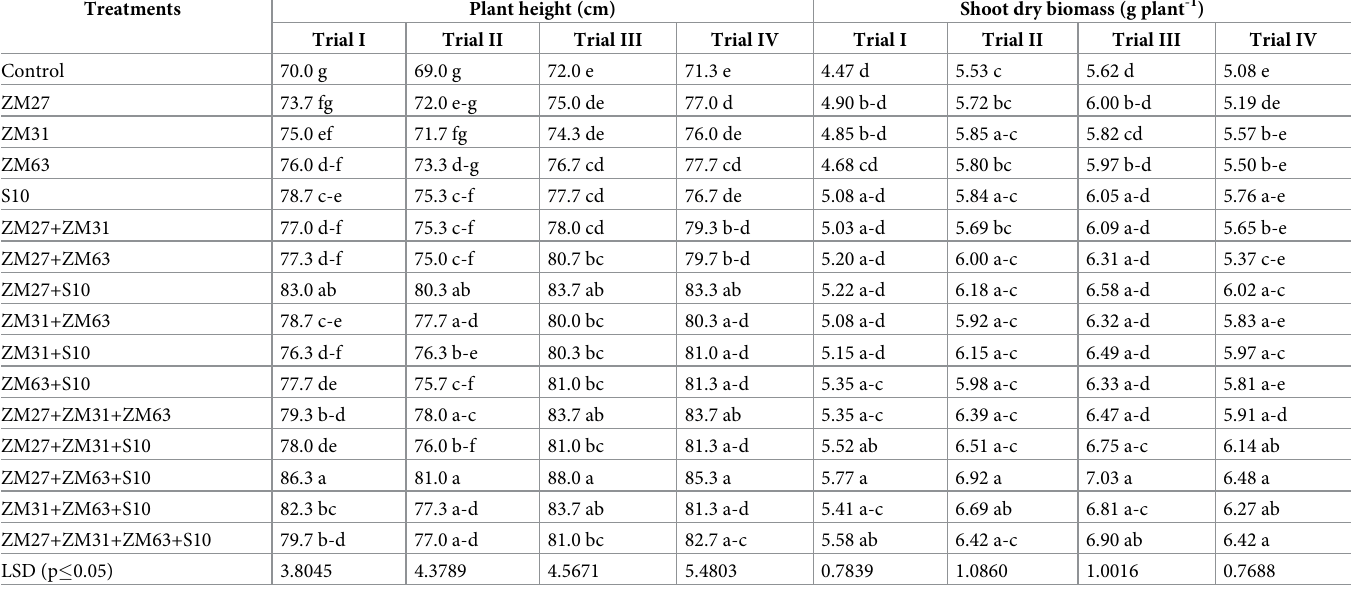
Table 2. Effects of novel bio-inoculants on plant height and shoot dry biomass of wheat in a field trial. Treatments